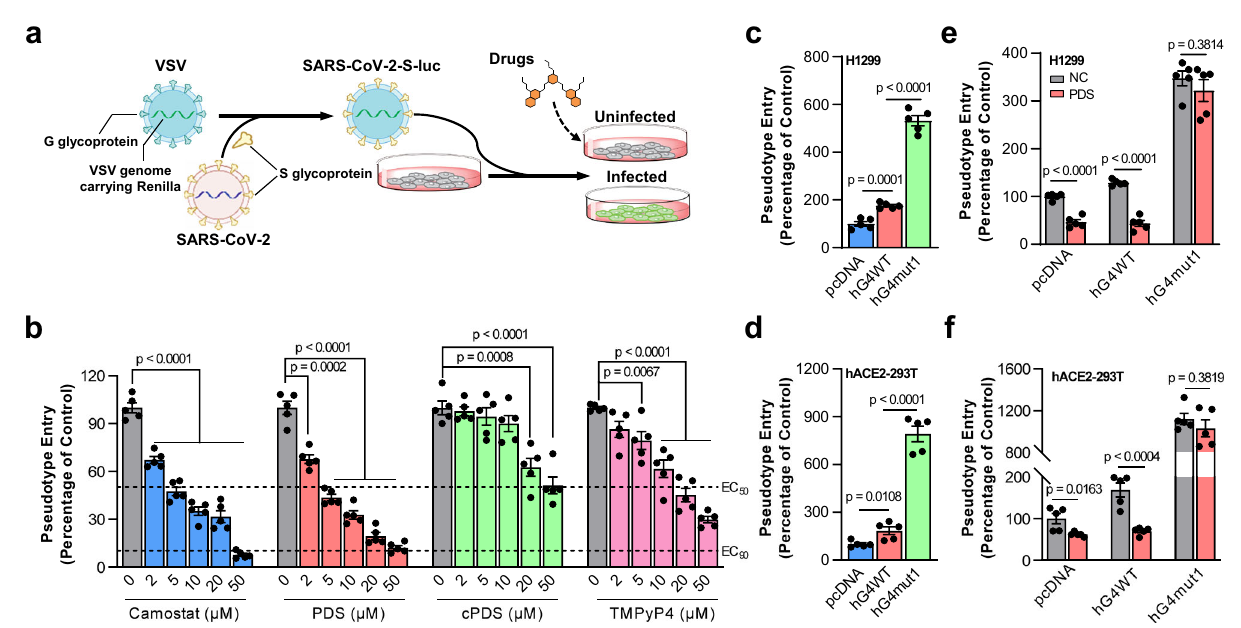
Fig. 3 RG4 inhibits SARS-CoV-2 pseudoviruses entry in vitro. a Schematic of the SARS-CoV-2 pseudoviruses entry system. The VSV viruses were pseudotyped with SARS-CoV-2 S glycoprotein (i.e., SARS-CoV-2-S-luc), and cells infected with SARS-CoV-2-S-luc for 48 h were then examined for luciferase activity. b SARS-CoV-2 pseudoviruses entry ef fi ciency with camostat mesylate, PDS, cPDS, or TMPyP4 treatment. H1299 cells were pre- incubated with the indicated concentrations of compounds, and subsequently inoculated with VSV-SARS-2-S-luc. 48 h post-inoculation, pseudoviruses entry was analyzed by determining luciferase activity in cell lysates (normalization against untreated cells). c , d Entry ef fi ciency of SARS-CoV-2 pseudoviruses in H1299 ( c ) and hACE2-293T ( d ) cells transfected with hG4WT or hG4mut1 plasmids. e , f Entry ef fi ciency of SARS-CoV-2 pseudoviruses in H1299 ( e ) and hACE2-293T ( f ) cells transfected with hG4WT or hG4mut1 plasmids and stimulated with PDS (10 μ M). Data are shown as mean ± SEM, n = 5. Two-tailed Student ’ s t test. Source data are provided as a source data fi